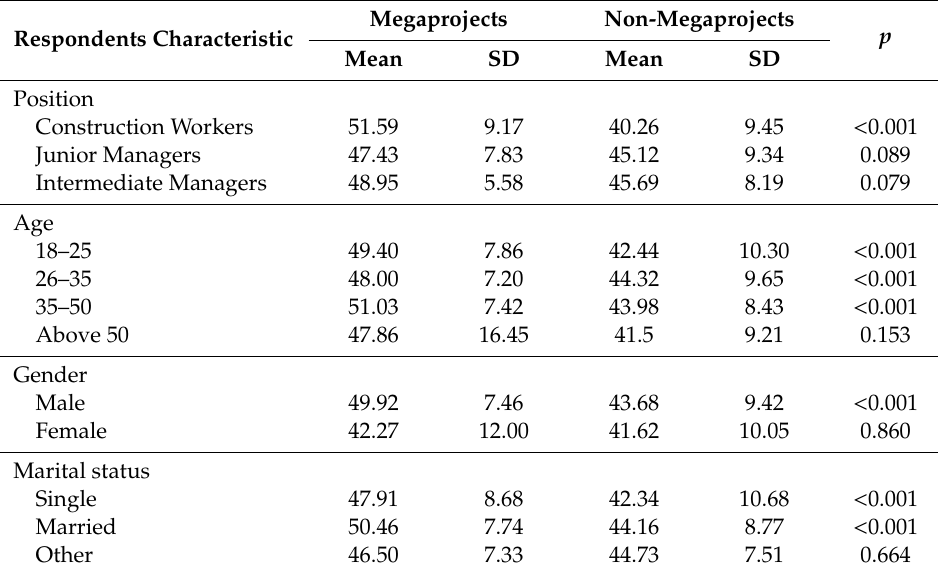
Table 7. Descriptive statistical results of PSC